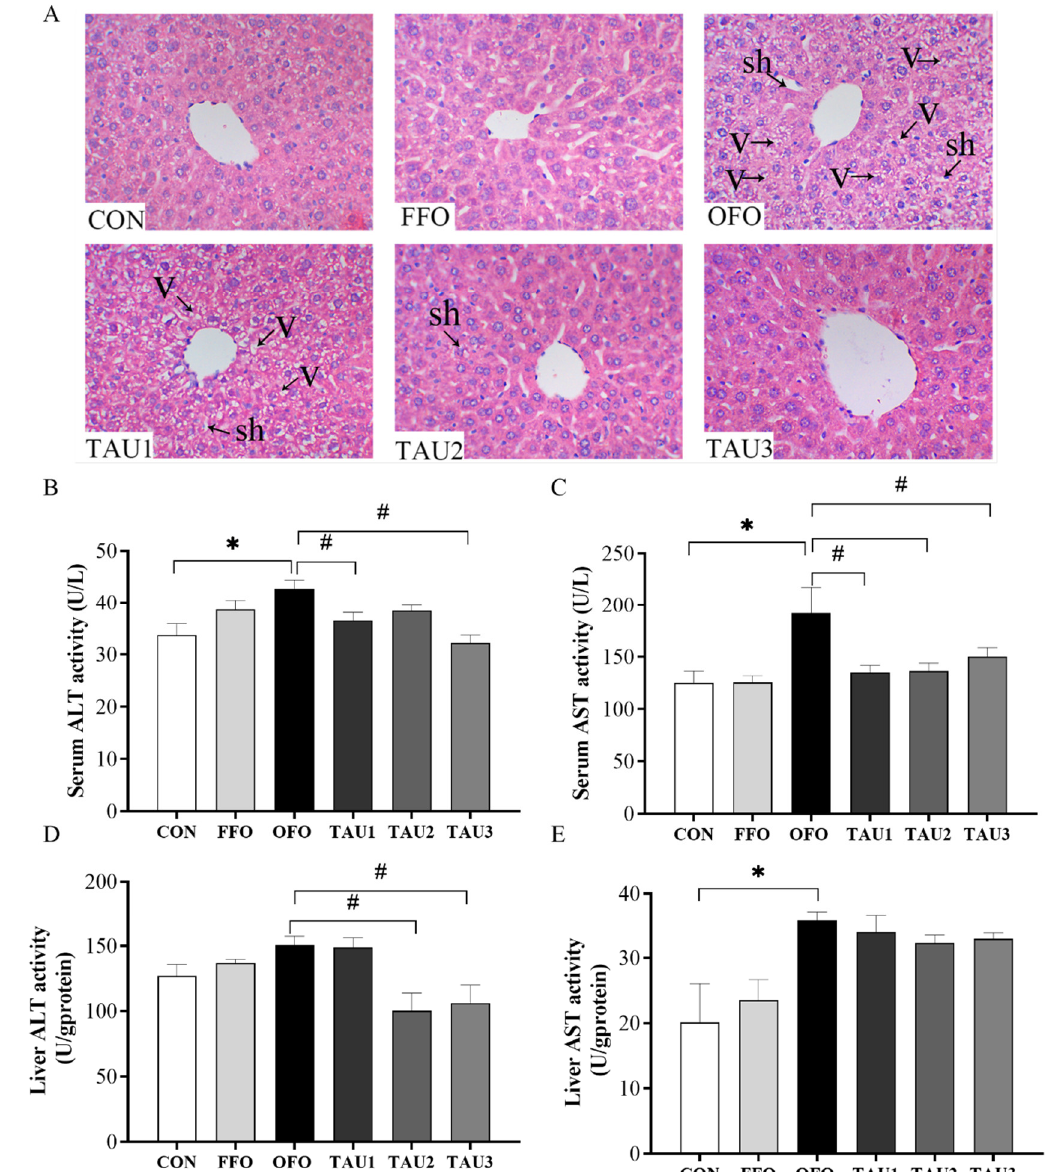
Figure 2. The liver histological findings (( A ), hematoxylin and eosin staining, Vacuolization (v), swelling of hepatocytes (sh), 400 × ), serum ALT ( B ), serum AST ( C ), liver ALT ( D ) and liver AST ( E ) of all groups of mice. ICR mice were fed a normal (CON), normal plus fish oil diet (FFO), normal plus oxidized fish oil diet (OFO), or OFO plus 0.6% (TAU1), 0.9% (TAU2) or 1.2% (TAU3) taurine diet for 10 weeks. Each value represents the mean ± SEM ( n = 10). * p < 0.05 vs. the CON group and # p < 0.05 vs. the OFO group. ALT, alanine aminotransferase; AST, aspartate transaminase.